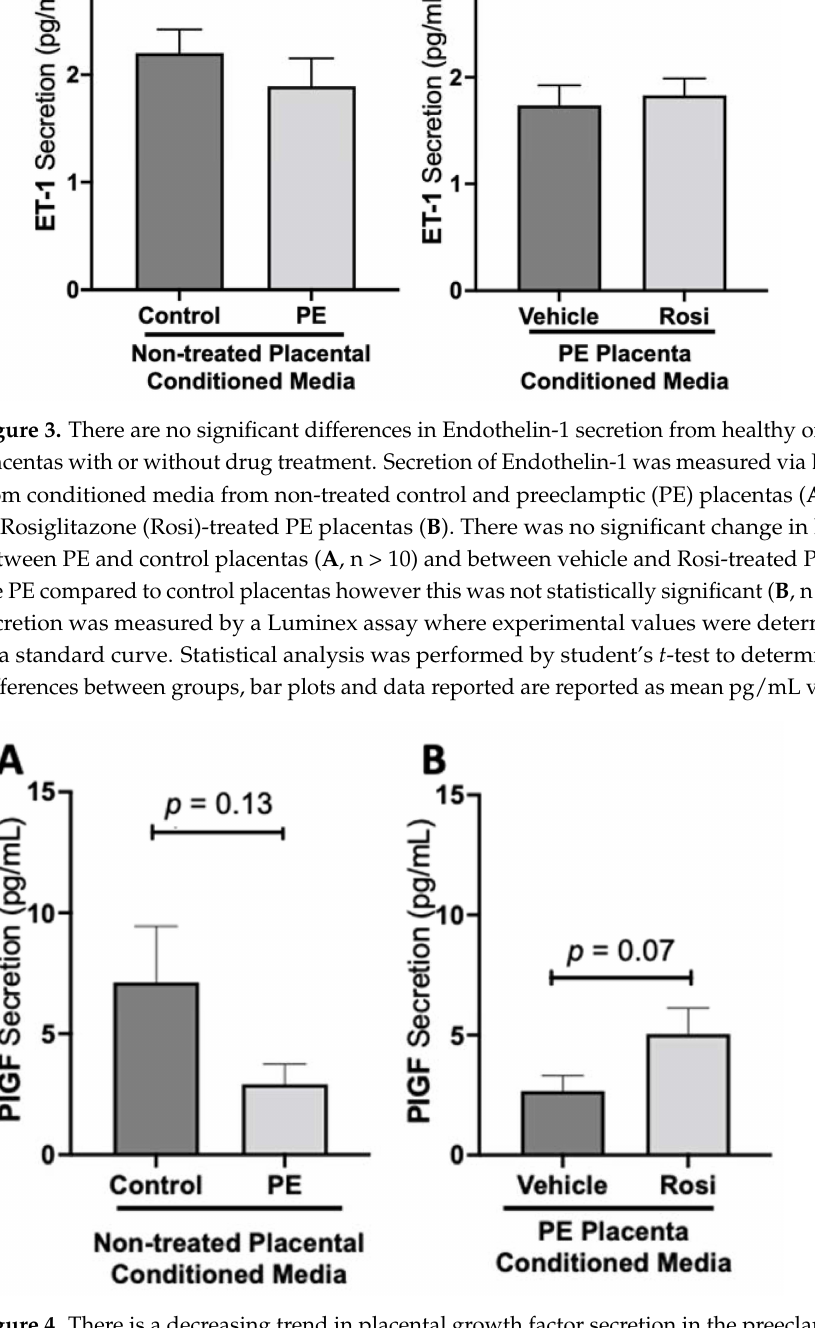
Figure 4. There is a decreasing trend in placental growth factor secretion in the preeclamptic placenta that is partially rescued by Rosiglitazone treatment. Secretion of Placental growth factor (PlGF) were measured via Luminex assay from conditioned media from non-treated control and preeclamptic (PE) placentas ( A ) and vehicle- or Rosiglitazone (Rosi)-treated PE placentas ( B ). There was a trending decrease of PlGF secretion in the PE compared to control placentas however this was not statistically significant ( A , n > 10). Rosi-treated PE placentas show an increase of PlGF secretion however this was not statistically significant when compared to the vehicle control ( B , n = 14). (Protein secretion was measured by a Luminex assay where experimental values were determined relative to a standard curve. Statistical analysis was performed by student’s t -test to determine significant differences between groups, bar plots and data reported are reported as mean pg/mL values ±